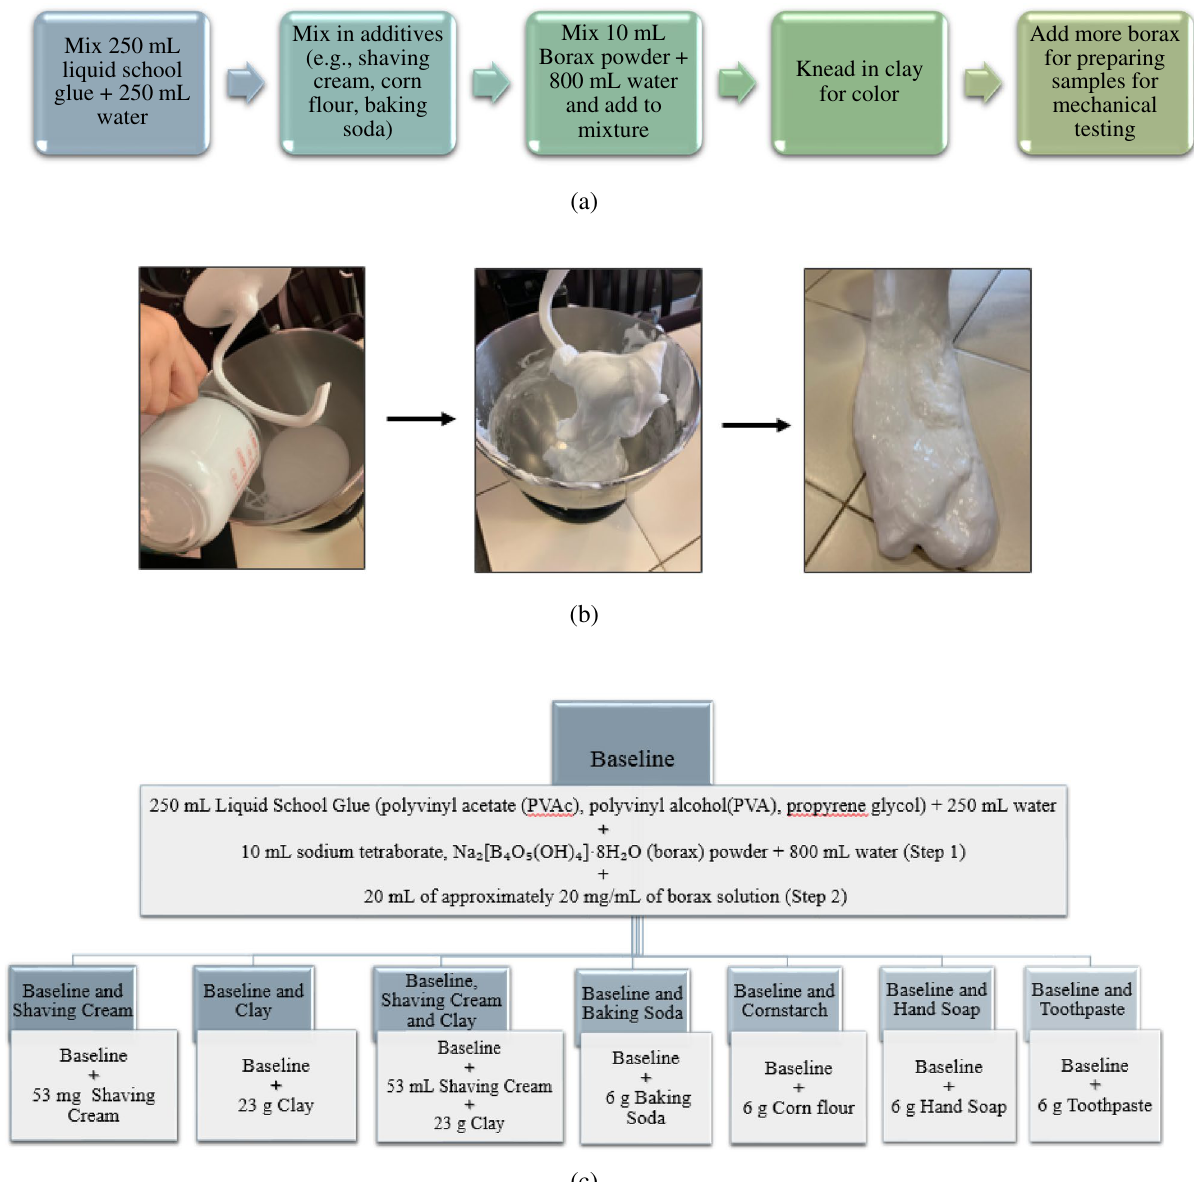
Figure 1. ( a ) Step-by-step process to make slime, ( b ) intermediate steps showing how adding borax leads to stiffening of slime, and ( c ) process flow to make eight different types of